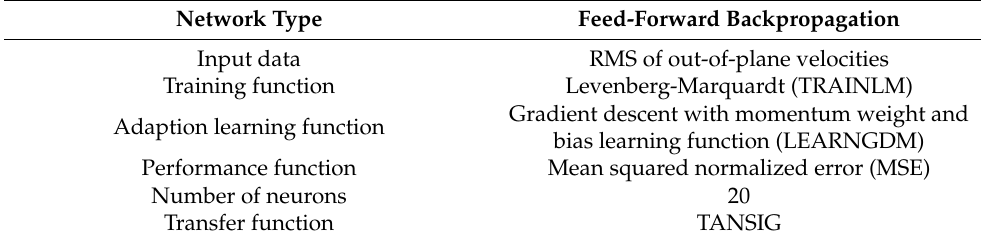
Table 1. ANN properties setup, (MathWorks®, Natick, MA, USA) [32].